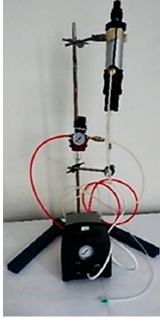
Figure 11. Volumetric precision low pressure doser.